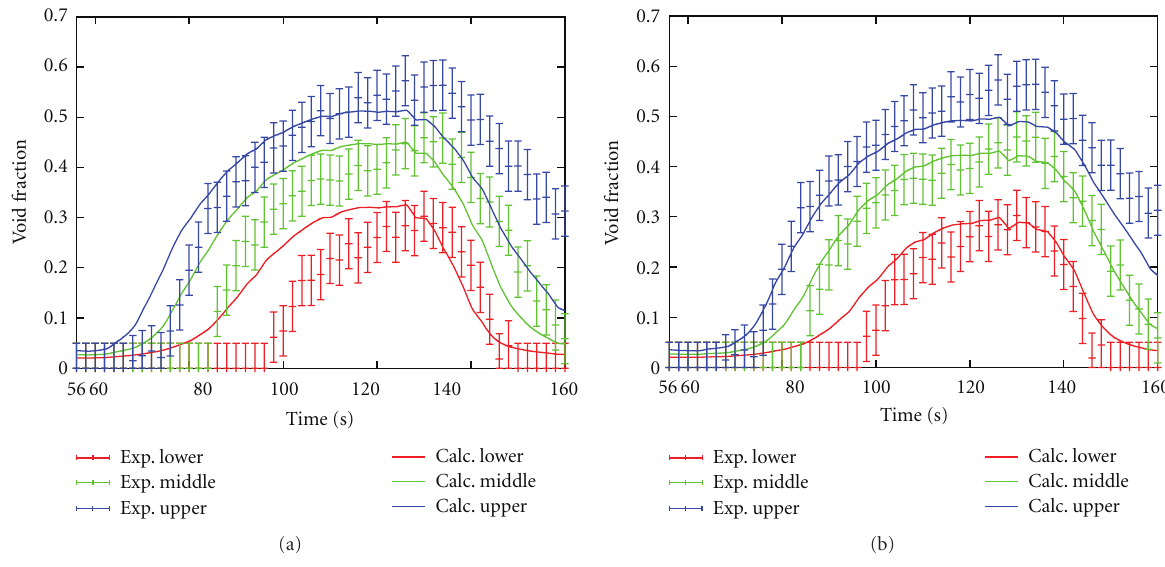
Figure 6: Temperature increase transient T6: original (a) and delayed (b) inlet temperature boundary conditions.